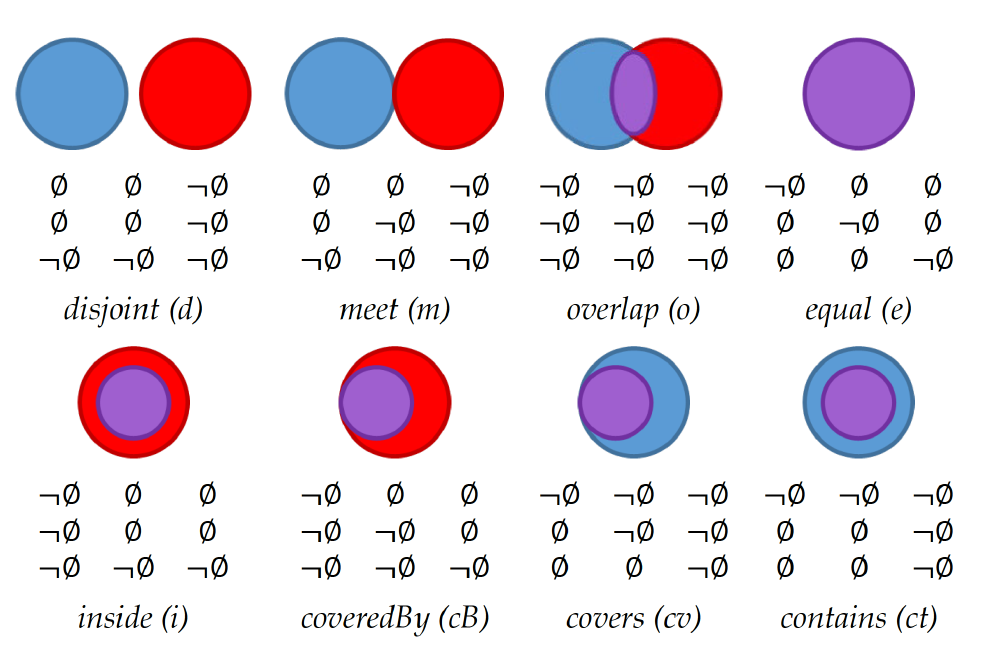
JOSIS, Number 23 (2021), pp.